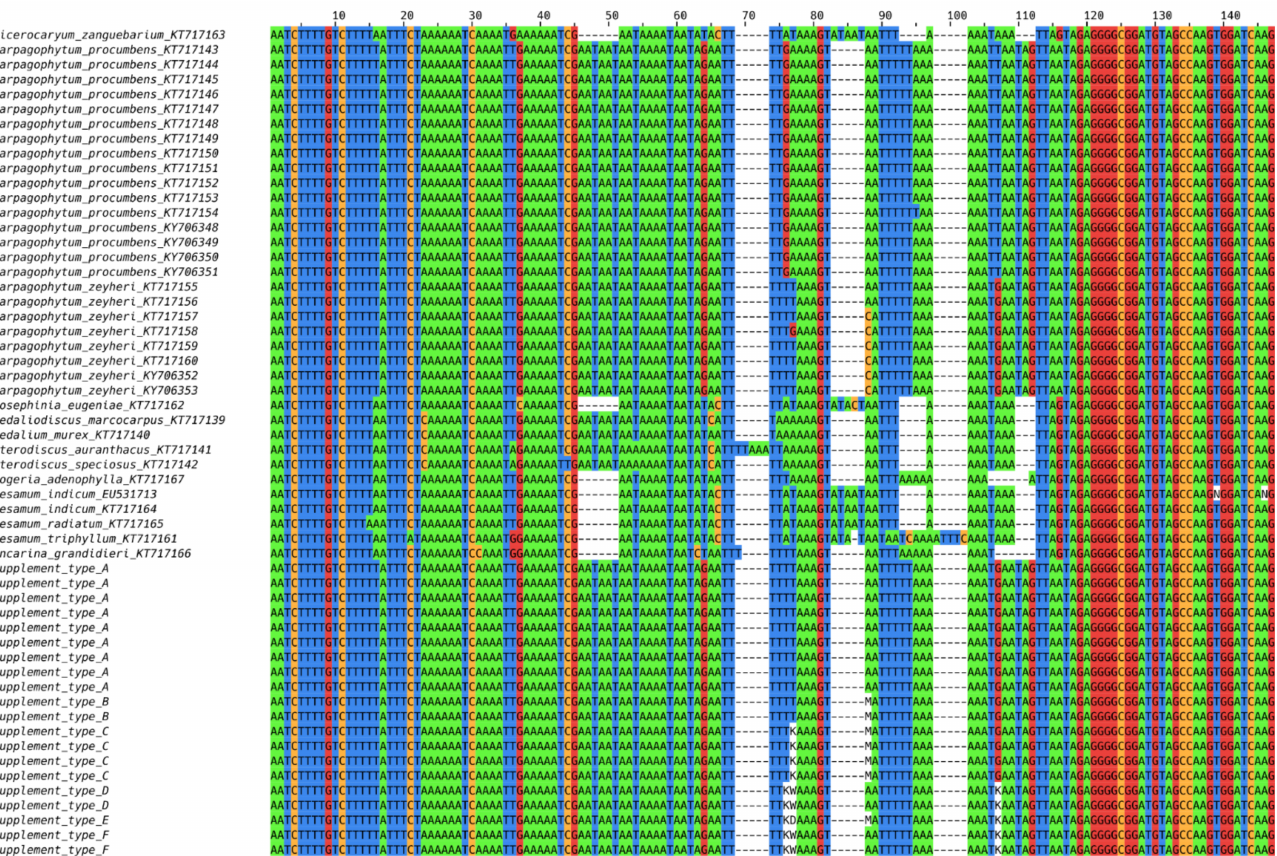
Figure A1. Full psbA-trnH mini-barcode